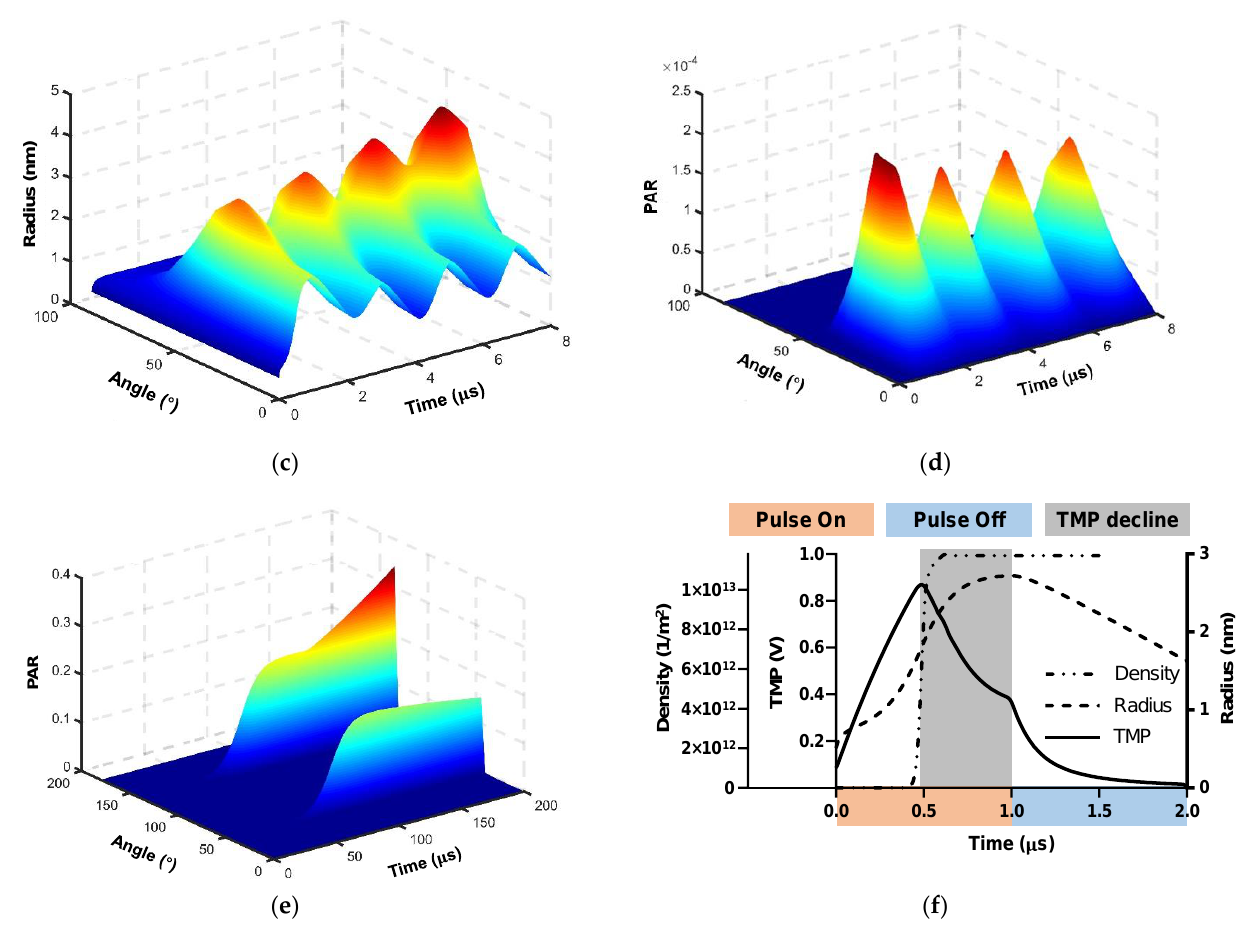
Figure 2. The temporal-spatial changings of ( a ) TMP, ( b ) pore density, ( c ) pore radius, ( d ) PAR in the short-term, and ( e ) PAR in the long-term under 1-1-1 protocol with 1000 V/cm, and ( f ) the TMP, pore density, and pore radius variation at the polar point ( 𝜃 = 0° ) under 1-1-1 protocol with 1000 V/cm.